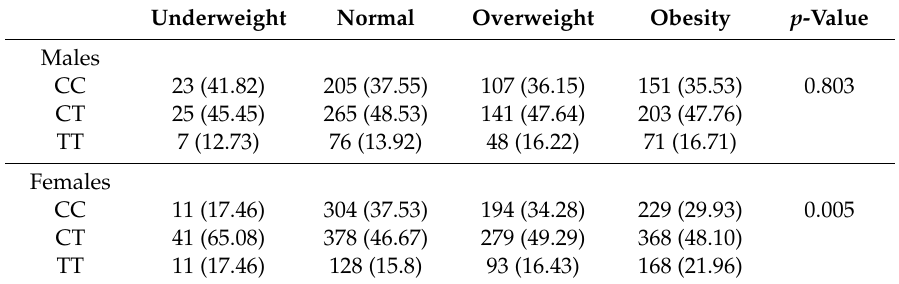
Table 4. Distribution of underweight, normal, overweight and obese subjects defined by their body mass index taking into account the TAS2R38 rs10246939 genotype and sex.